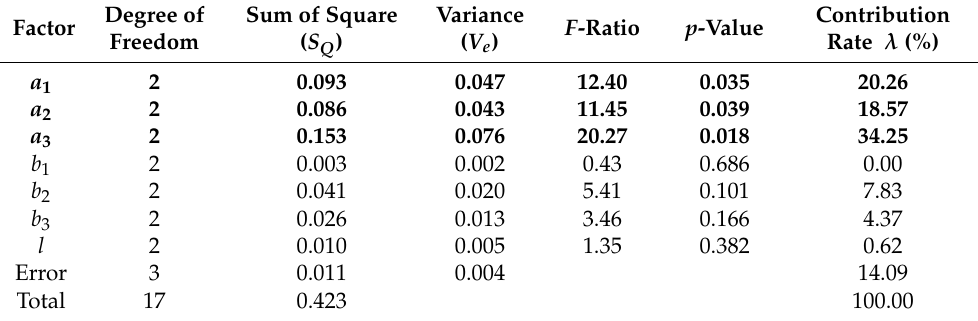
Table 6. ANOVA for 630 Hz.